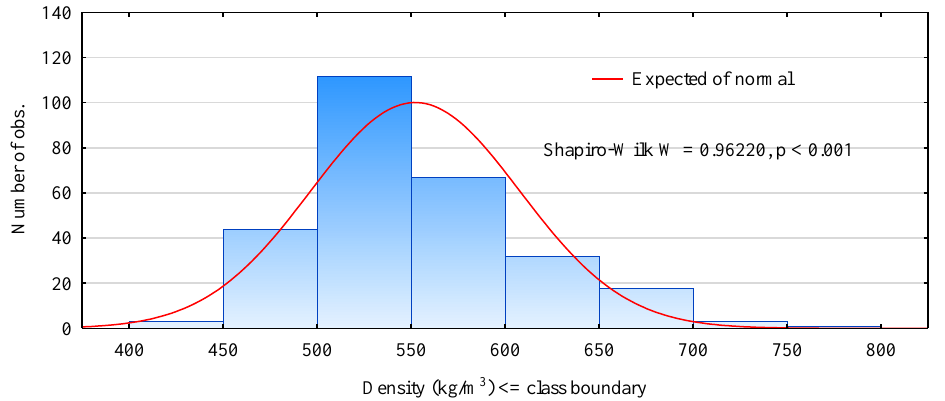
Figure 4. A histogram of the distribution of density for tested timber. The use of the sample mean as a measure of the central trend is common, and typi- cally, it rather well describes the sample median. Unfortunately, it is related to a normal distribution. Figure 5 presents box plots for the assessment of density based on the mean and median. The mean density of timber differs by as little as slightly below 10 kg/m 3 , i.e., less than 2% from the median. Half of the tested population is characterised by densities between 513 and 580 kg/m 3 ; i.e., it is high but consistent with other data concerning density of pine originating from Poland. However, it needs to be stressed that even timber of the lowest density meets in this respect the requirements of the standards for structural timber of high mechanical